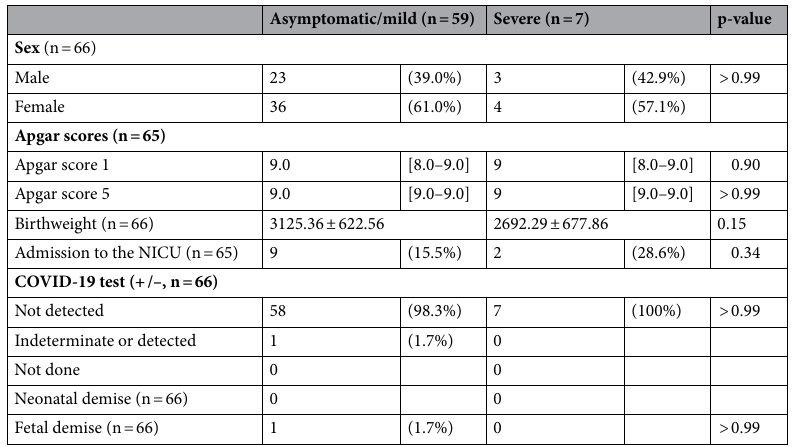
Table 3. Neonatal clinical outcomes, based on severity of maternal COVID-19 symptoms. *The categorical values are expressed as n (%), the continuous variables are expressed as either median [IQR] or mean ± SD.